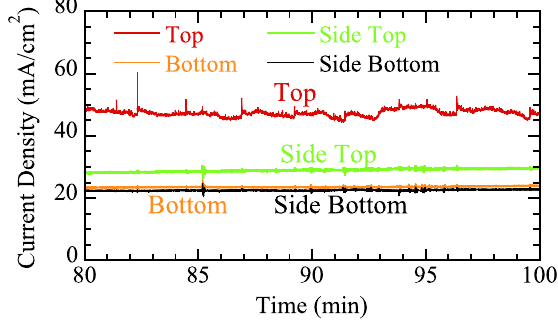
FIG. 11. Current density profiles for the Nb samples located at different positions relative to the cathode.